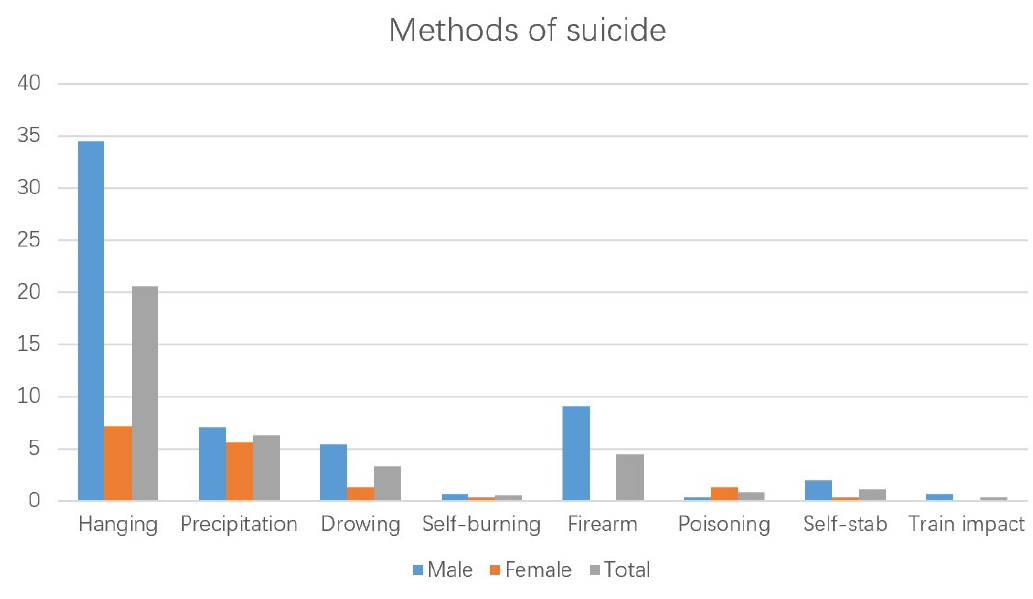
Fig. 3. Methods of suicide (cases per 100,000